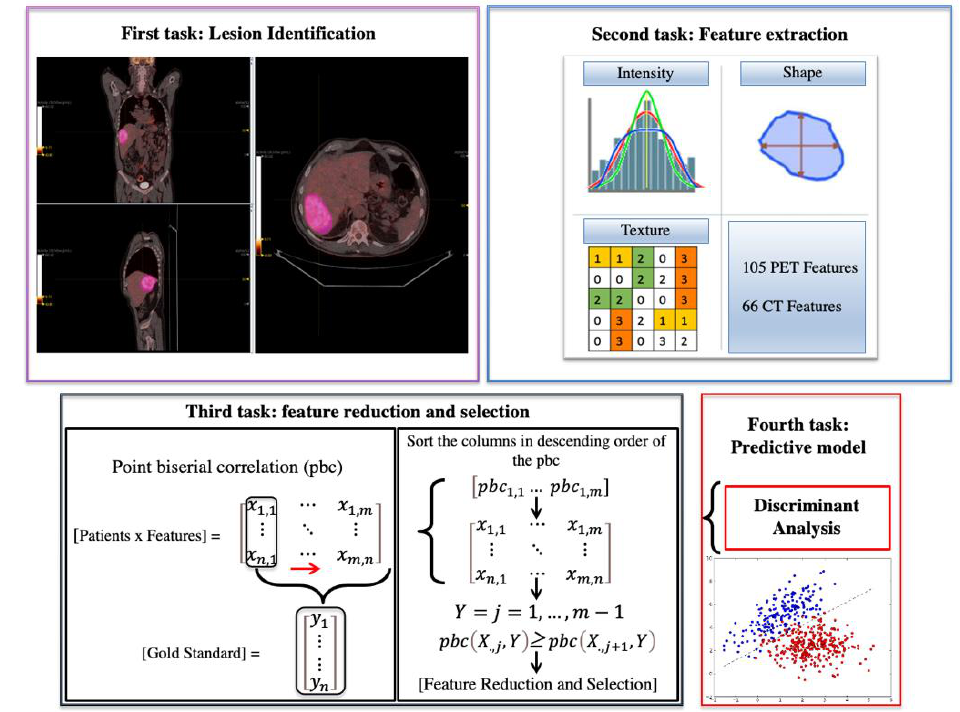
Figure 1. Radiomics flow chart applied in this study.